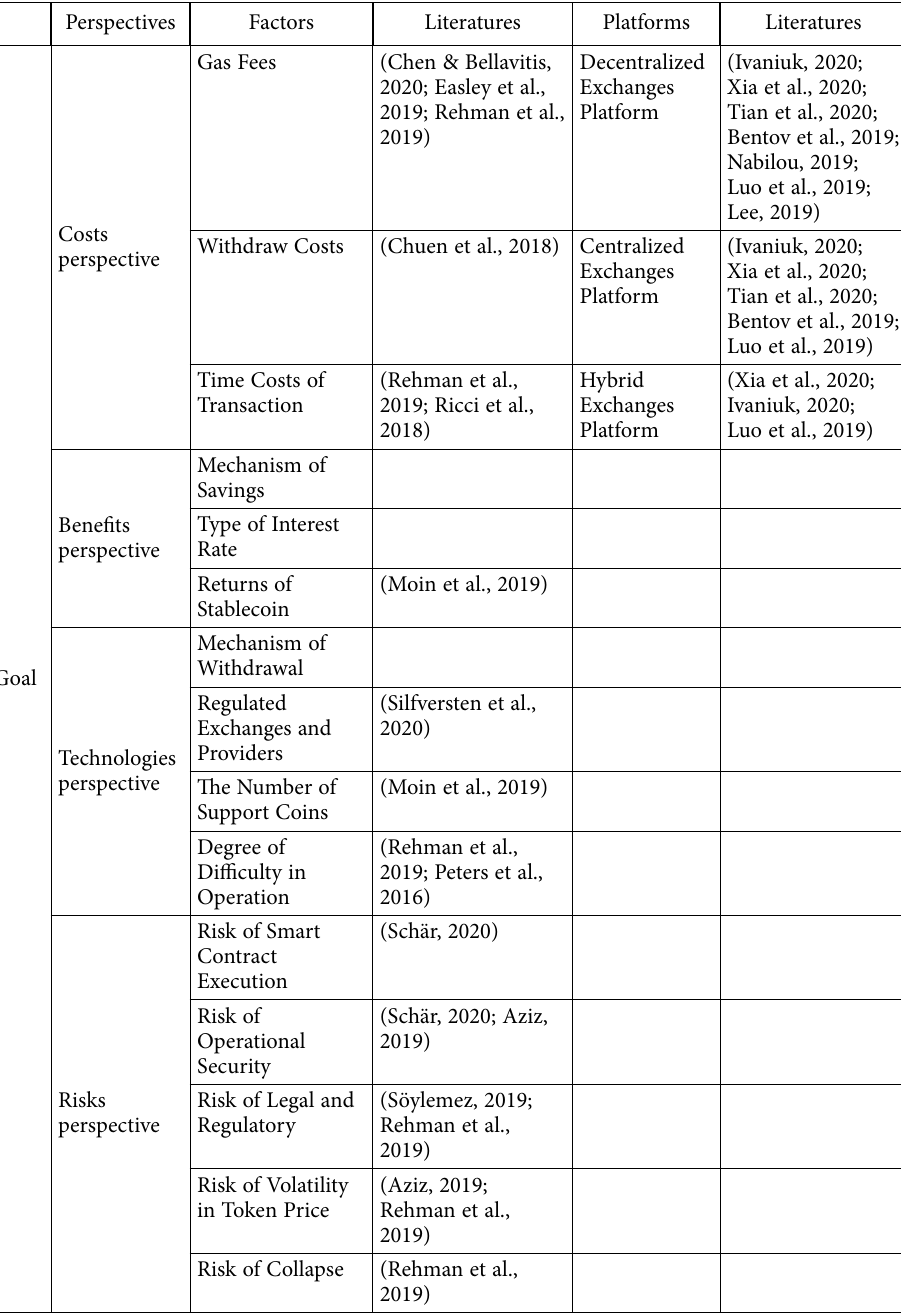
Table 5. The perspectives, factors and platforms